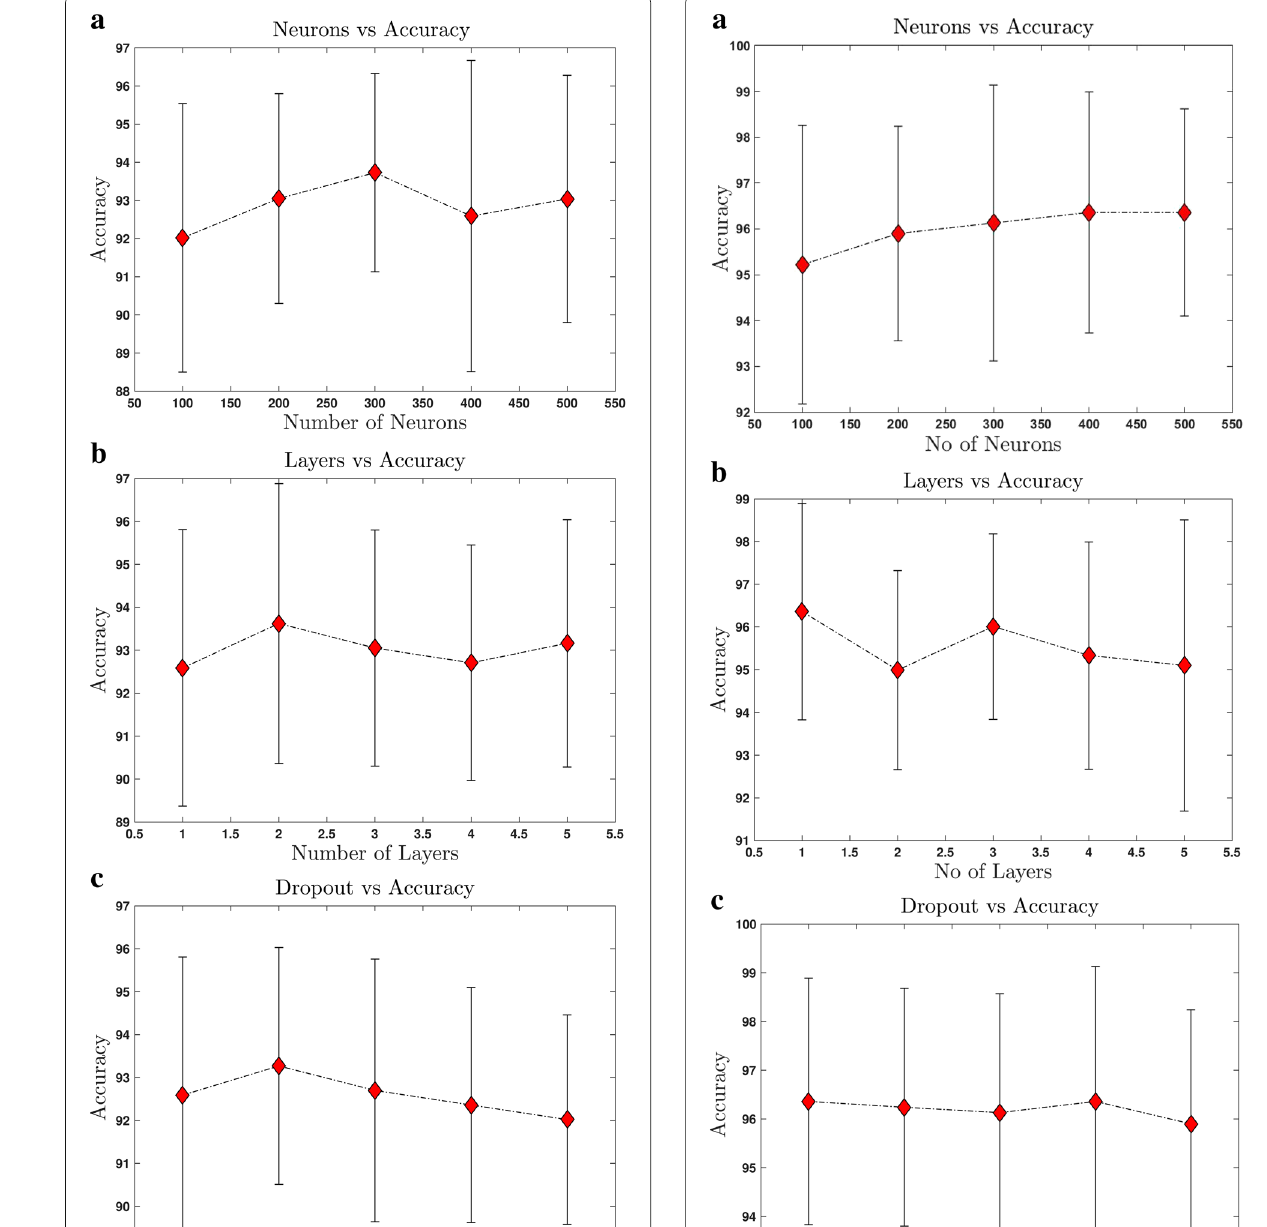
it is a technique where randomly selected neurons are ignored during training. They are dropped-out randomly. ward pass and any weight updates are not applied to the